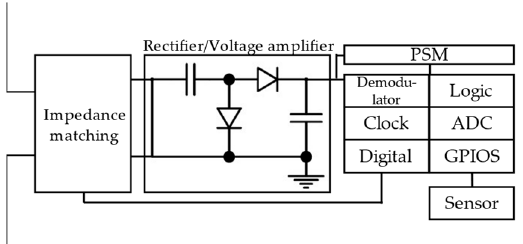
Figure 11. Schematic of digital integrated RFID sensor tag.